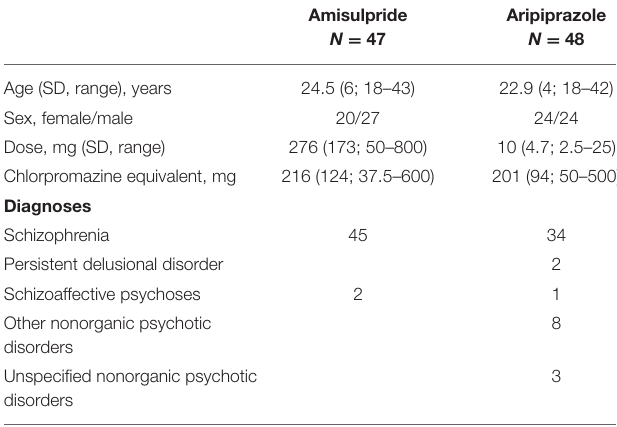
TABLE 1 | Demography, antipsychotic dose, and diagnoses for both